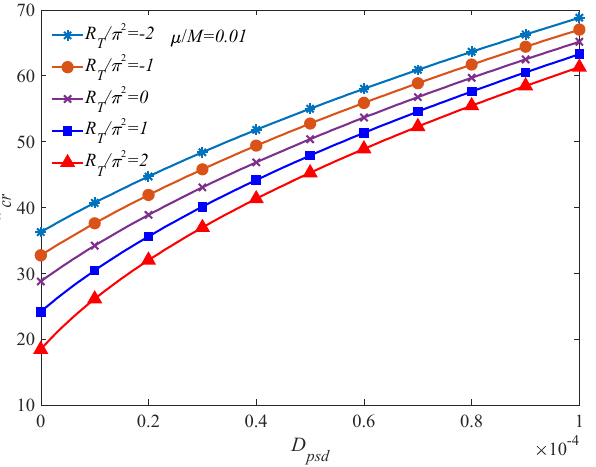
Figure 7. Critical dynamic pressure vs. pre-stretch displacement under different temperature elevations. The influence of pre-stretch displacement on the flutter frequency of the panel under different temperature elevations is shown in Figure 8, where µ / M = 0.01. For heated panels, the temperature rise reduces the flutter frequency of the panel and the temperature drop increases the flutter frequency. When the pre-stretch displacement D psd = 10 − 4 m and R T / π 2 = 0, the flutter frequency ω cr = 65.14 increases sharply by 223.42% compared to that at D psd = 0. Compared with other methods in the literature, such as those of Arena et al. [9] and Zhao and Cao [13], the increase in the critical dynamic pressure and flutter frequency by applying pretension to the panel in this paper is highly remarkable.